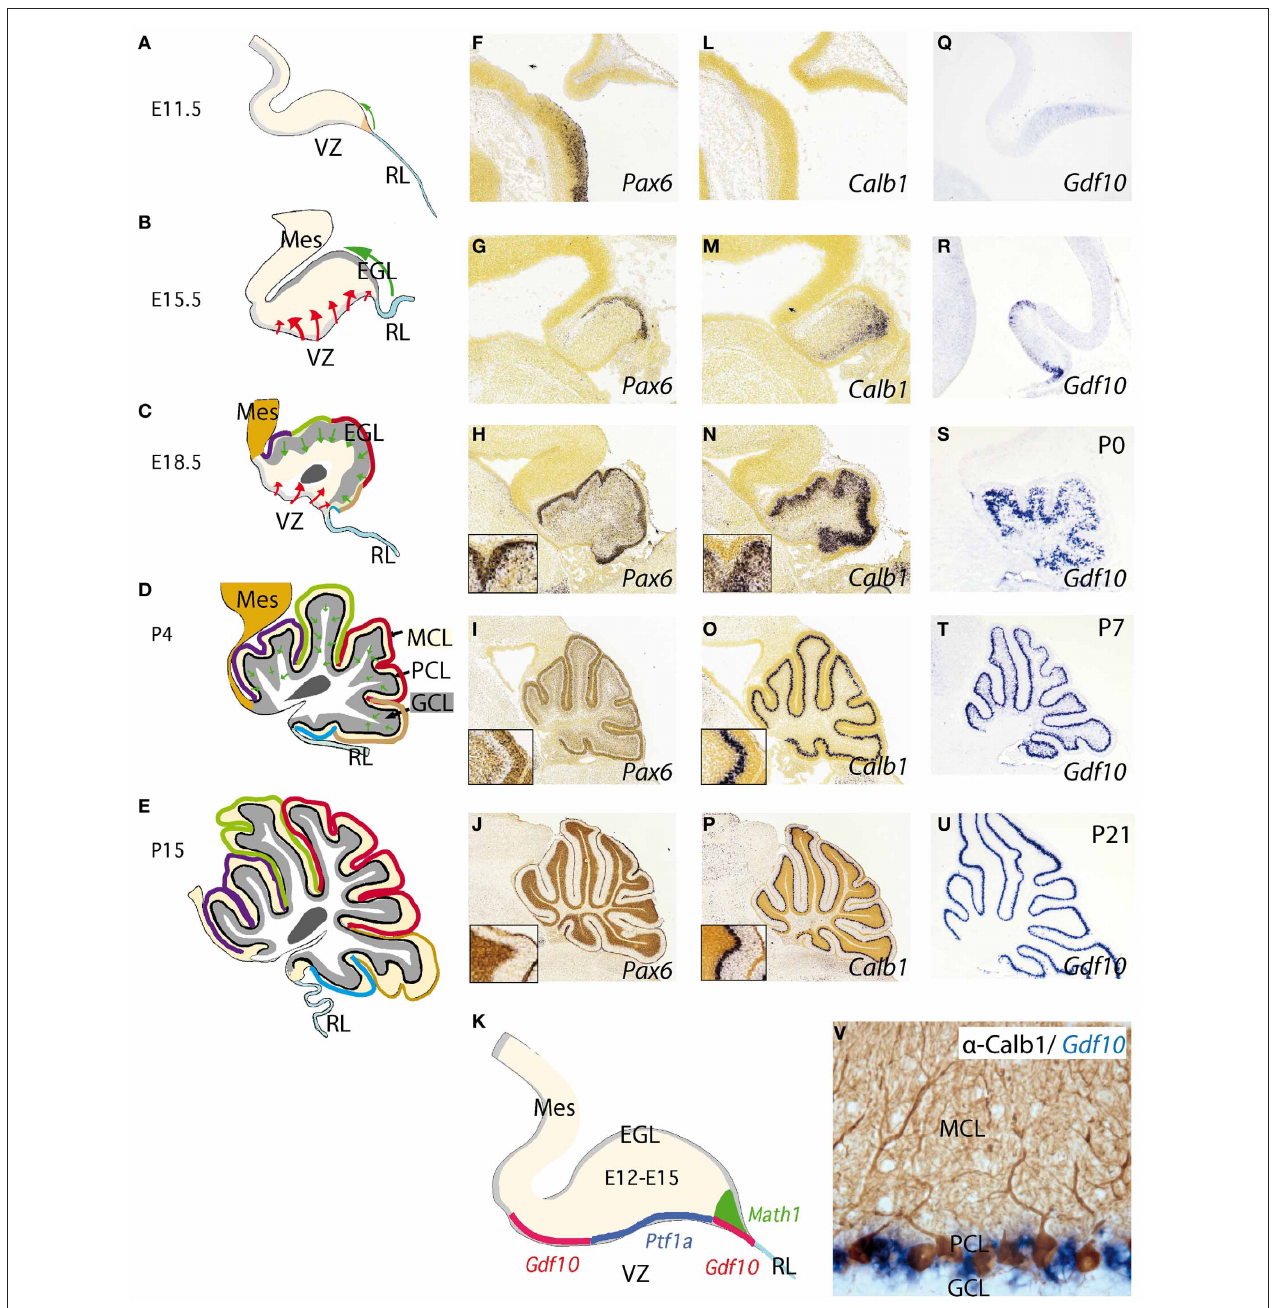
FIGURE 2 | Developmentofthecerebellumfromtherhombencephalicalar platefrom earlystagesto adulthood.(A–E) Cerebellar morphology/anatomy at different stages of development.The cerebellar folia developmentis showed from E11.5 onwards identifying the corresponding folia primordia bulgesas color code lines from rostral to caudal (see also Sudarovand Joyner, 2007). Tangential migration from the rhombic lip (RL) is indicated as a green arrow corresponding to excitatory granule precursor cells that are specified by theexpressionof Math1 (K) . Thesecells build uptheexternalgranulecell layer and from neonatal stages to P14, they descend radially forming the internal granule cell layer (GCL) located below Purkinje cell layer (PCL). The red arrows highlight the radial migration of cells originating from the ventricular zone (VZ). This is where Purkinje cells (PCs) and GABAergic cells of the cerebellum are bornand specifiedbythe early expressionof Ptf1a (K) ; see also Dastjerdi et al.